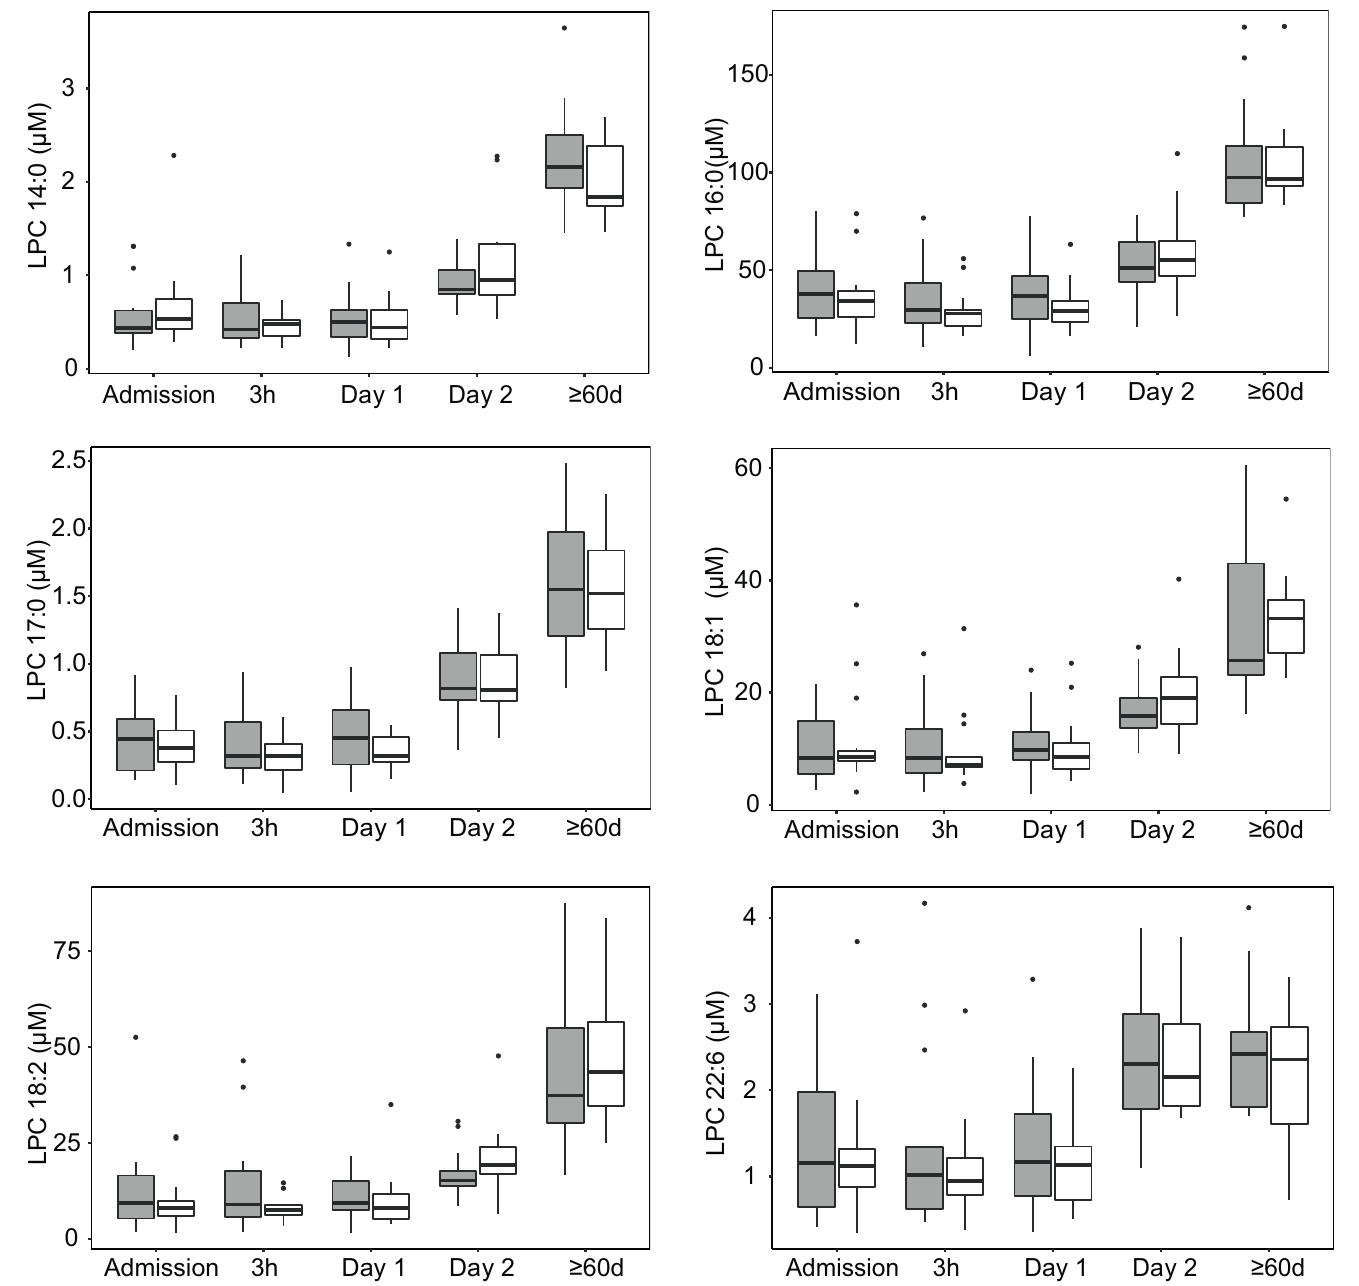
Fig 4. Boxplot diagrams showing concentration distributions of LPC 14:0, 16:0, 17:0, 18:1, 18:2, and 22:6 at the different sampling time points. These LPC species showed reliable early disease stage concentration changes. Females are shown in gray boxes and males in white boxes. Outliers are shown as dots. Abbreviations: LPC,